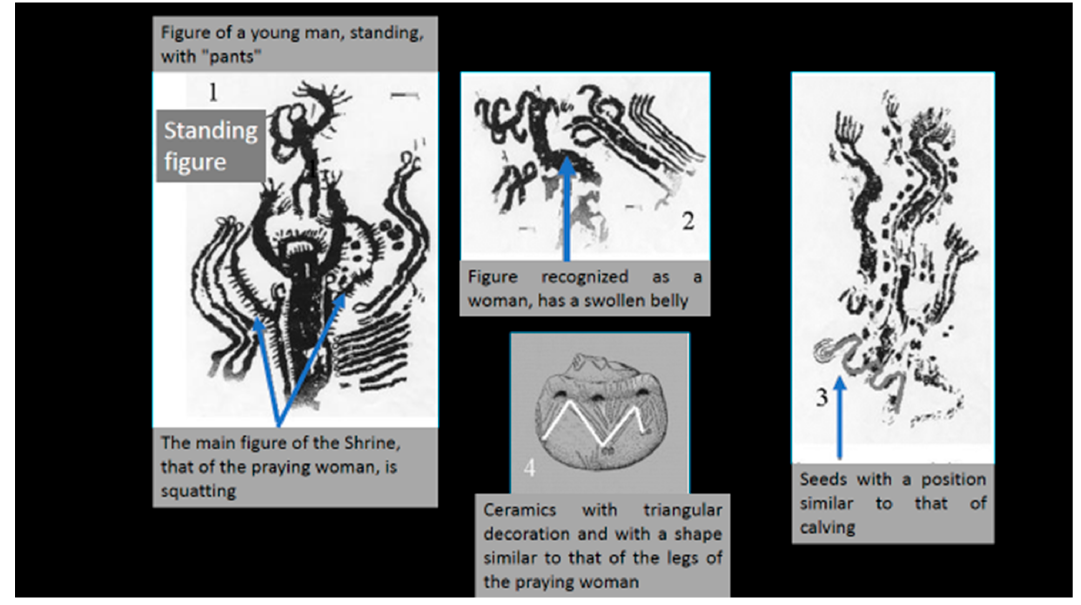
Figure 19. Pictures illustrating childbirth.